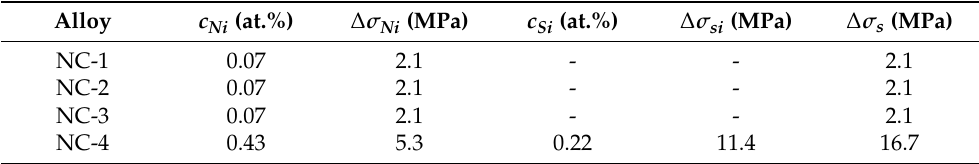
Table 4. Relevant parameters and theoretical values of the solid solution strengthening.